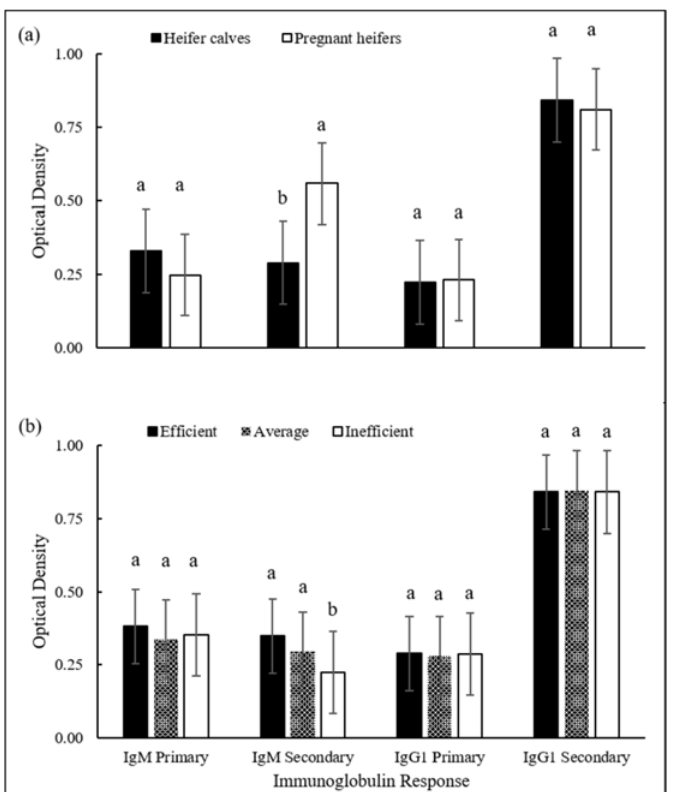
Figure 1. Specific immune response of immunoglobulins M (IgM) and G1 (IgG1) to ovalbumin in beef heifers; ( a ) heifer calves and pregnant heifers; and ( b ) heifer calves by feed efficiency groups (efficient, average and inefficient). Differing superscript denotes p < 0.05, according to the Scheffé multiple comparison test and error bars are the 95% confidence interval.